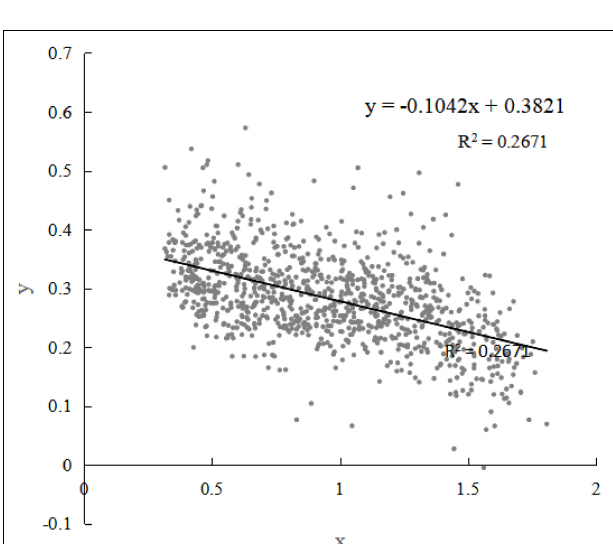
trends, which only increased slightly, with the variation slopes of 0.08 and 0.07,